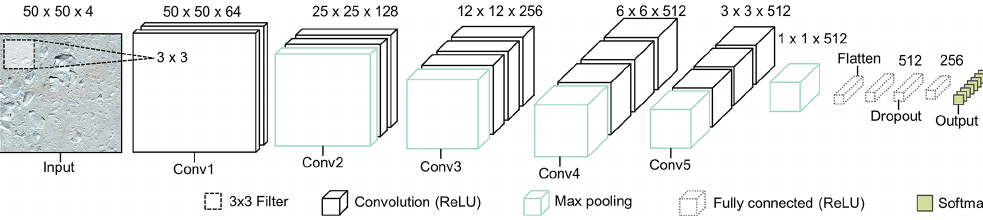
Figure 4. Architecture of phase one CNN, adapted from the original VGG16 model architecture (Simonyan and Zisserman, 2015). Diagram shows an example with a 50 × 50px RGBNIR input image tile. There are five stacks of 2D convolutional layers (labelled “Conv#”) which extract features from input tiles using a 3 × 3 filter. The convolutional stacks are followed by a fully connected neural network and Softmax activation for phase one class prediction. The Sentinel-2 image in this figure is courtesy of the European Union Copernicus programme.